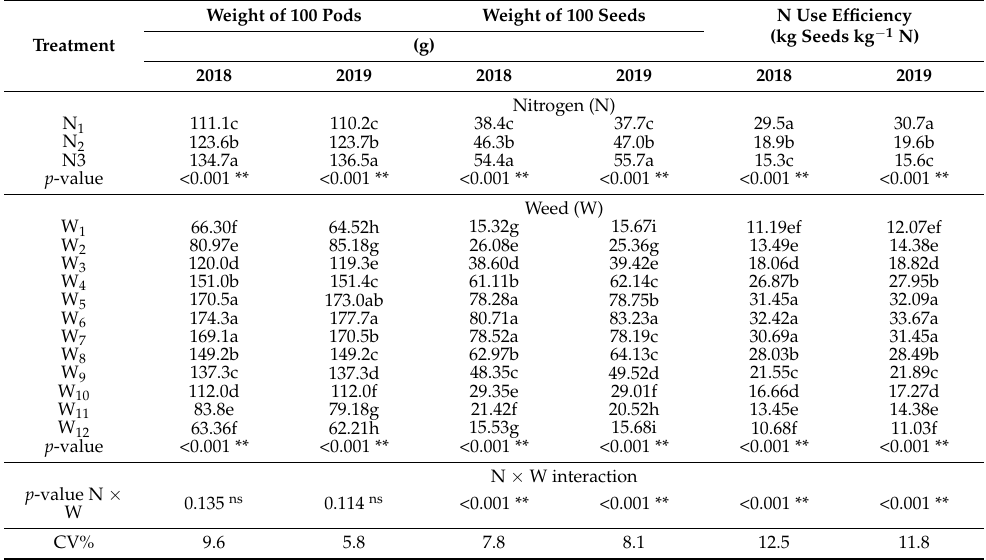
Table 6. Effect of nitrogen fertilization levels (N) and time (early and late) weed removal (W) on weight of 100 pods and 100 seeds, and N use efficiency of peanut ( Arachis hypogaea L.) in the 2018 and 2019